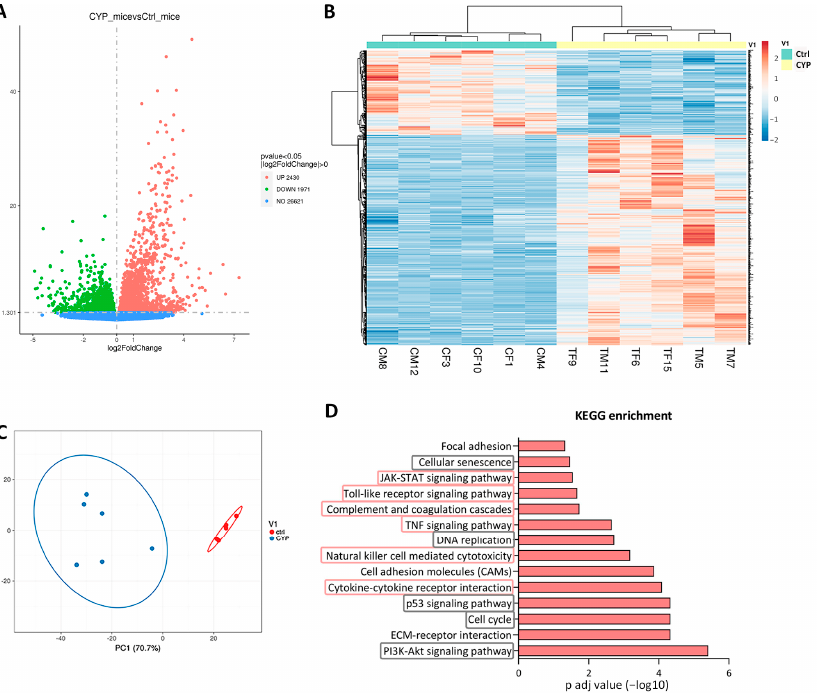
Figure 2. Effects of CYP treatment on the complete transcriptome of mouse bladders. ( A ) A volcano plot showing upregulated (red), downregulated (green), and unchanged (blue) genes in CYP vs. Ctrl mice. ( B ) Heatmap showing the 1000 most significantly DEGs in CYP (yellow; n = 6) vs. Ctrl (green; n = 6) animals ( p adj < 0.05). Both rows and columns are clustered using correlation distance and average linkage. Lower expression is indicated in blue, and higher expression is indicated in red. CM: Ctrl male; CF: Ctrl female; TM: CYP-treated male; TF: CYP-treated female. ( C ) PCA of the 1000 most significantly DEGs in CYP (blue; n = 6) vs. Ctrl (red; n = 6) animals ( p adj < 0.05), showing principal components 1 and 2 (PC1 and PC2) explaining 70.7% and 7.5% of the total variance, re- spectively. Unit variance scaling was applied to rows, and singular value decomposition (SVD) with imputation was used to calculate principal components. The prediction ellipses are such that with a probability of 0.95, a new observation from the same group will fall inside the ellipse. ( D ) KEGG enrichment analysis based on all DEGs in CYP ( n = 6) vs. Ctrl ( n = 6) animals ( p adj < 0.05), showing relevant significantly enriched pathways, represented as − log10 of the p adj value. Processes in- volved in cell proliferation are circled in gray, while processes of immune response are circled in pink.